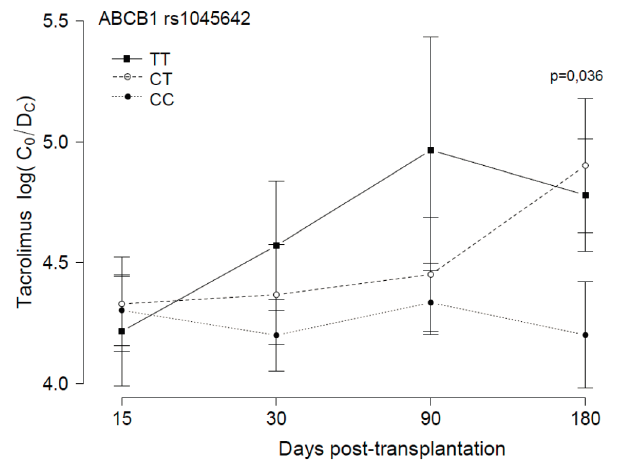
Figure 1. Tacrolimus blood concentration in relation to the ABCB1 rs1045642 genotype. Tacrolimus corrected (dose/weight) trough concentrations (C 0 /D c , [(ng/mL)/(mg/kg/24 h)]) are plotted (mean and standard deviation of all the measurements in each period) in relation to the ABCB1 rs1045642 genotype of 40 lung transplant patients, during the first six months